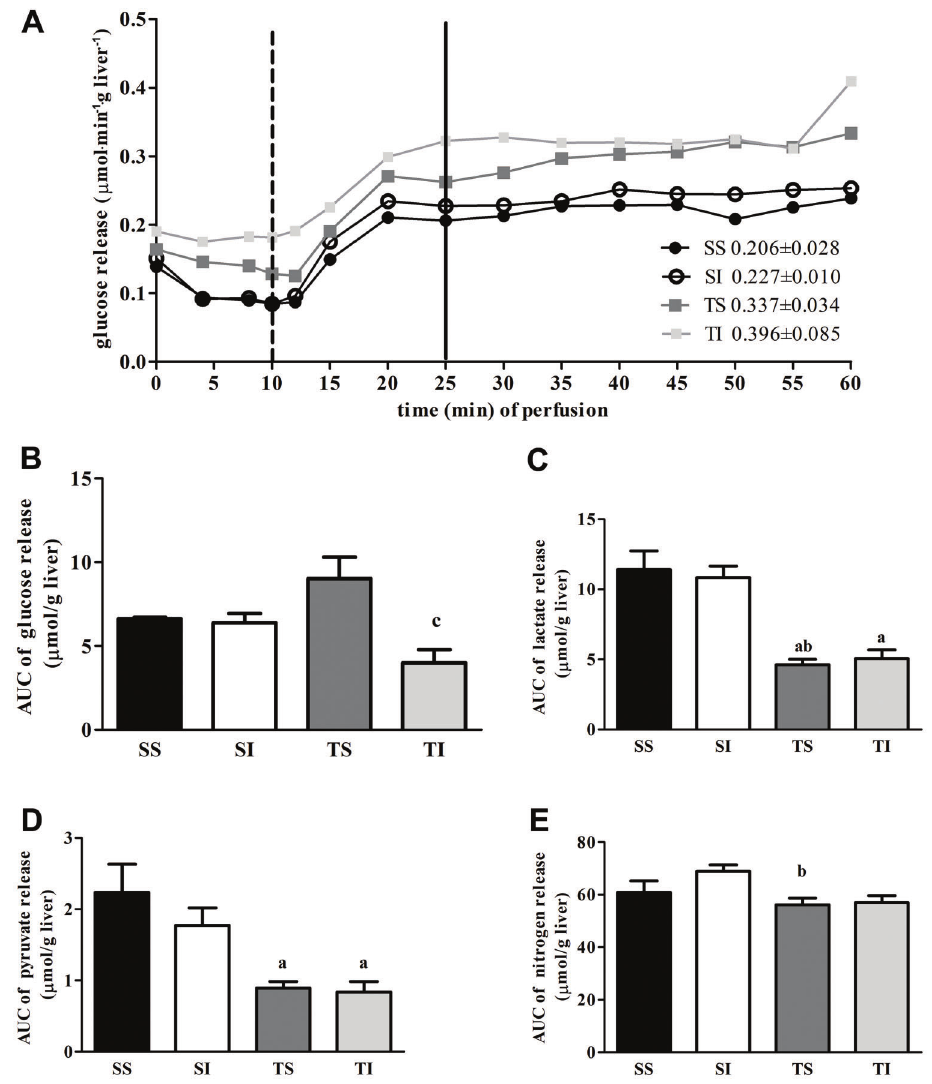
Figure 5. Kinetics and steady-state ( A , numerical values) of liver glucose release and area under curve (AUC) of glucose ( B ), lactate ( C ), pyruvate ( D ), and nitrogen ( E ) release during perfusion with alanine + glutamine of Swiss mice of groups SS: sedentary treated with saline; SI: sedentary treated with insulin; TS: trained treated with saline; and TI: trained treated with insulin. Data are reported as means ± SE for n=5-7/group. a P o 0.05 vs SS; b P o 0.05 vs SI; c P o 0.05 vs TS